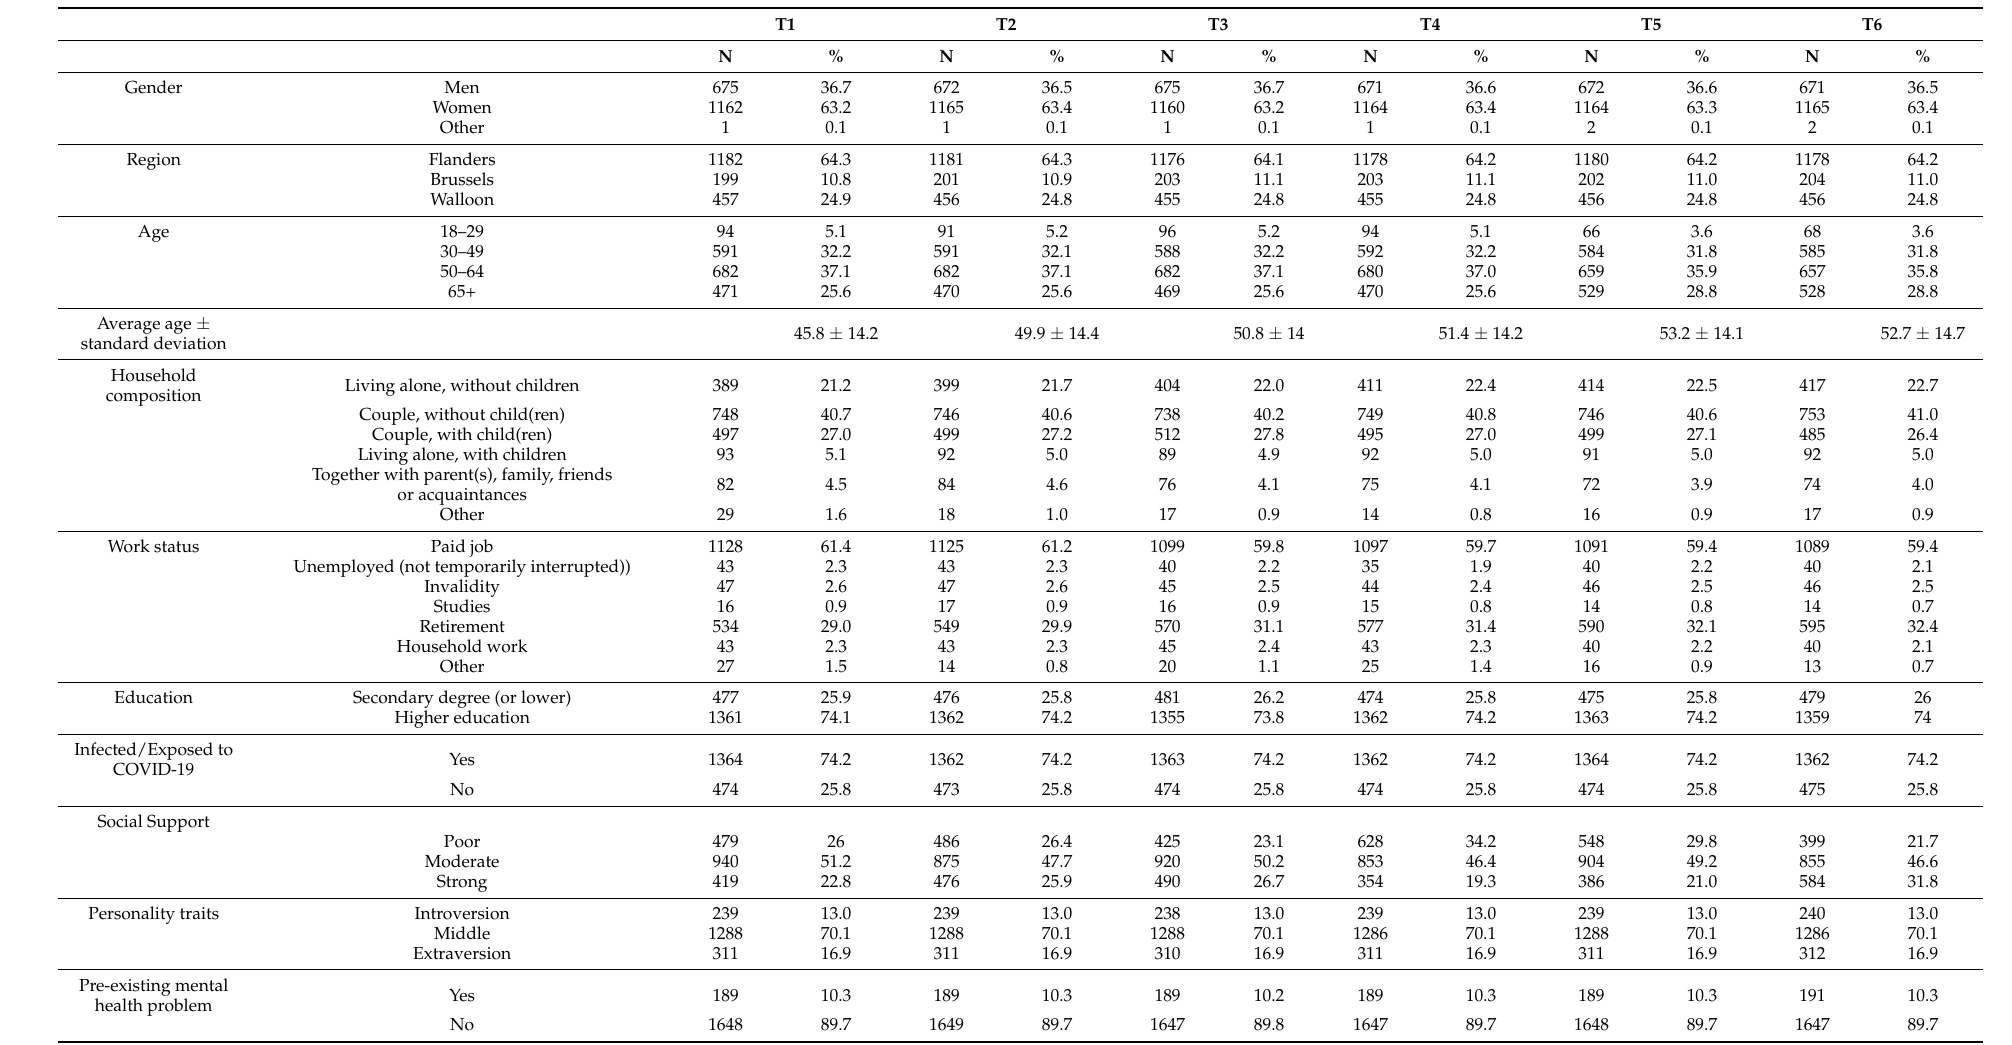
Table 2. Descriptive analysis of the longitudinal data: people who participated in all 6 waves (crude